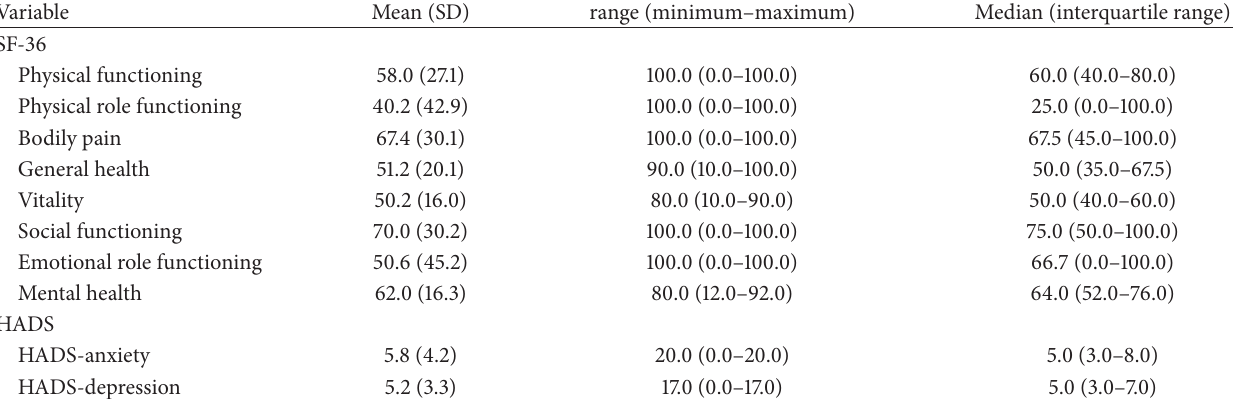
Table 2: Health-related quality of life, anxiety, and depression among Iranian liver transplant candidates ( 𝑛 = 205 ).